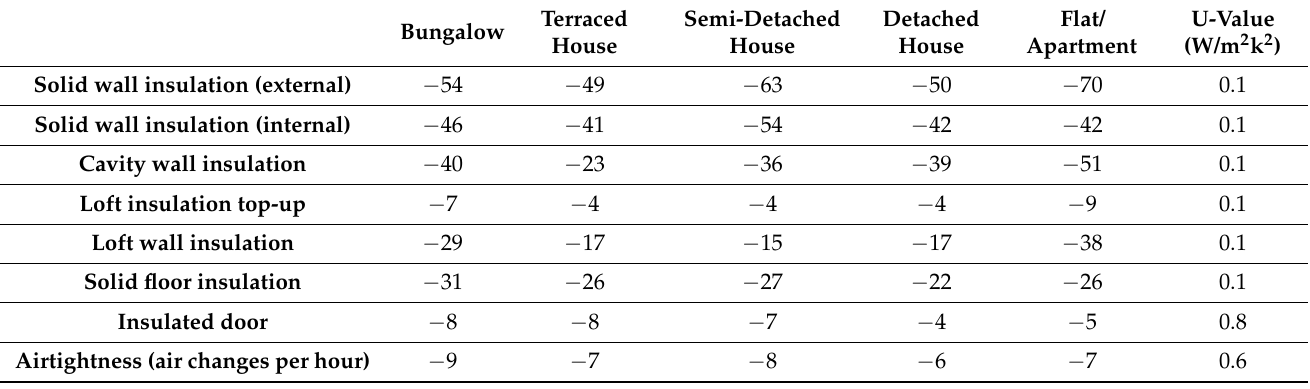
Table A3. Change in demand (kWh/m 2 ) per measure per house type (applicable to Passive Scenario).